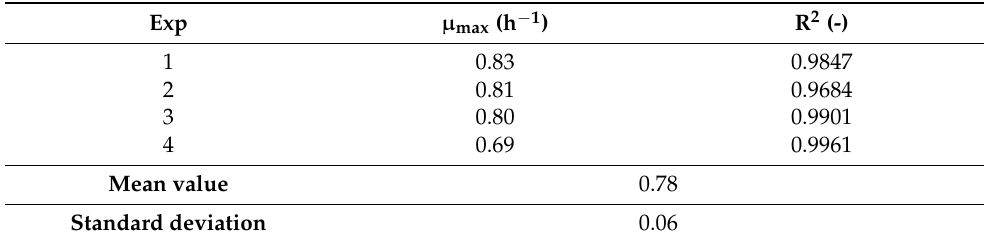
Figure 3. Evolution of ln (OD 600 ) with time during the exponential growth phase, for four indepen- dent experiments. Table 2. Values obtained for the maximal growth rate ( µ max